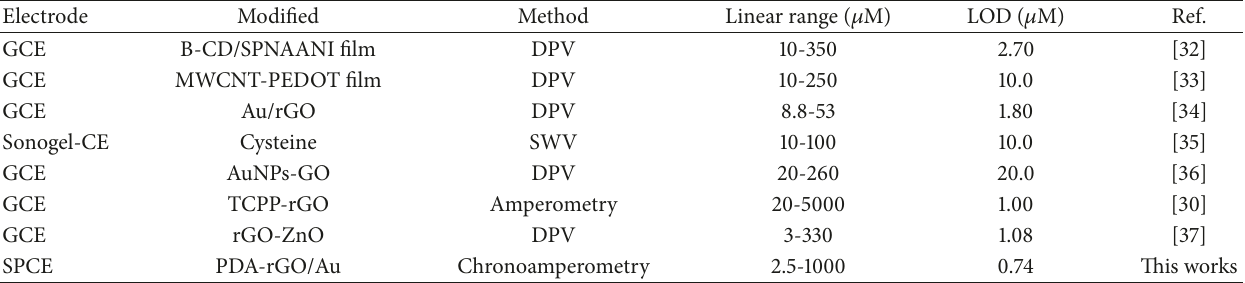
Figure 6: Chronoamperograms at the PDA-rGO/Au in 0.1 M PBS pH 6.0 containing different concentrations of uric acid at +0.25 V versus Ag/AgCl ink. The inset shows (a) the calibration curve for uric acid detection, n = 3, and (b) the enlarged chronoamperograms of uric acid from 0 to 80 𝜇 M. Table 1: Comparative analytical performance of this as-prepared sensor and some others for the uric acid determination.